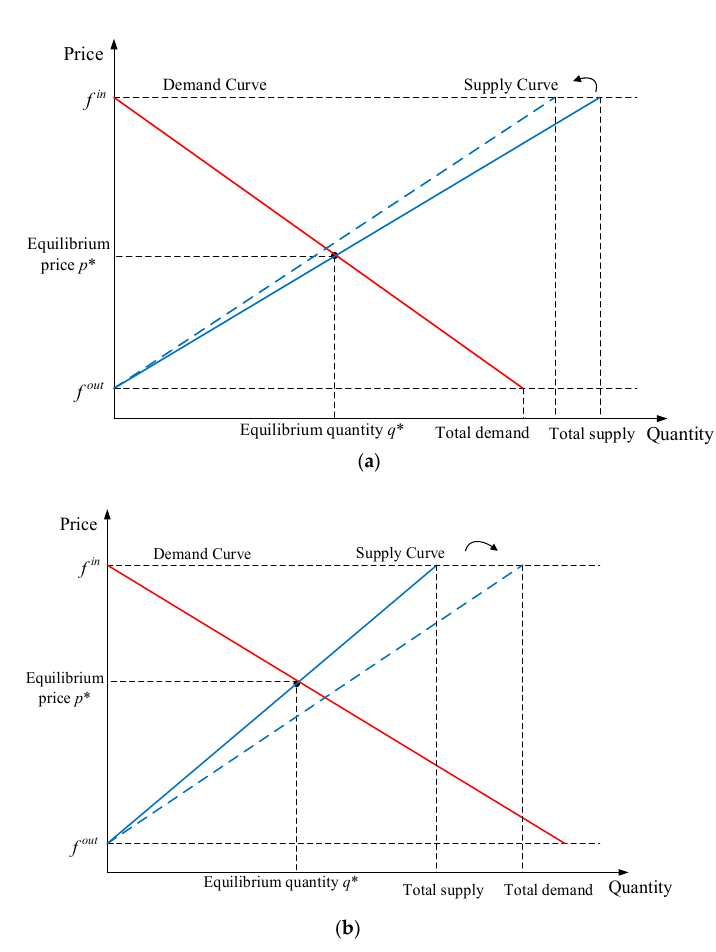
Figure 3. ( a ) Dynamic adjustment process (charging) when supply is greater than demand, ( b ) dynamic adjustment process (discharging) when supply is less than demand.